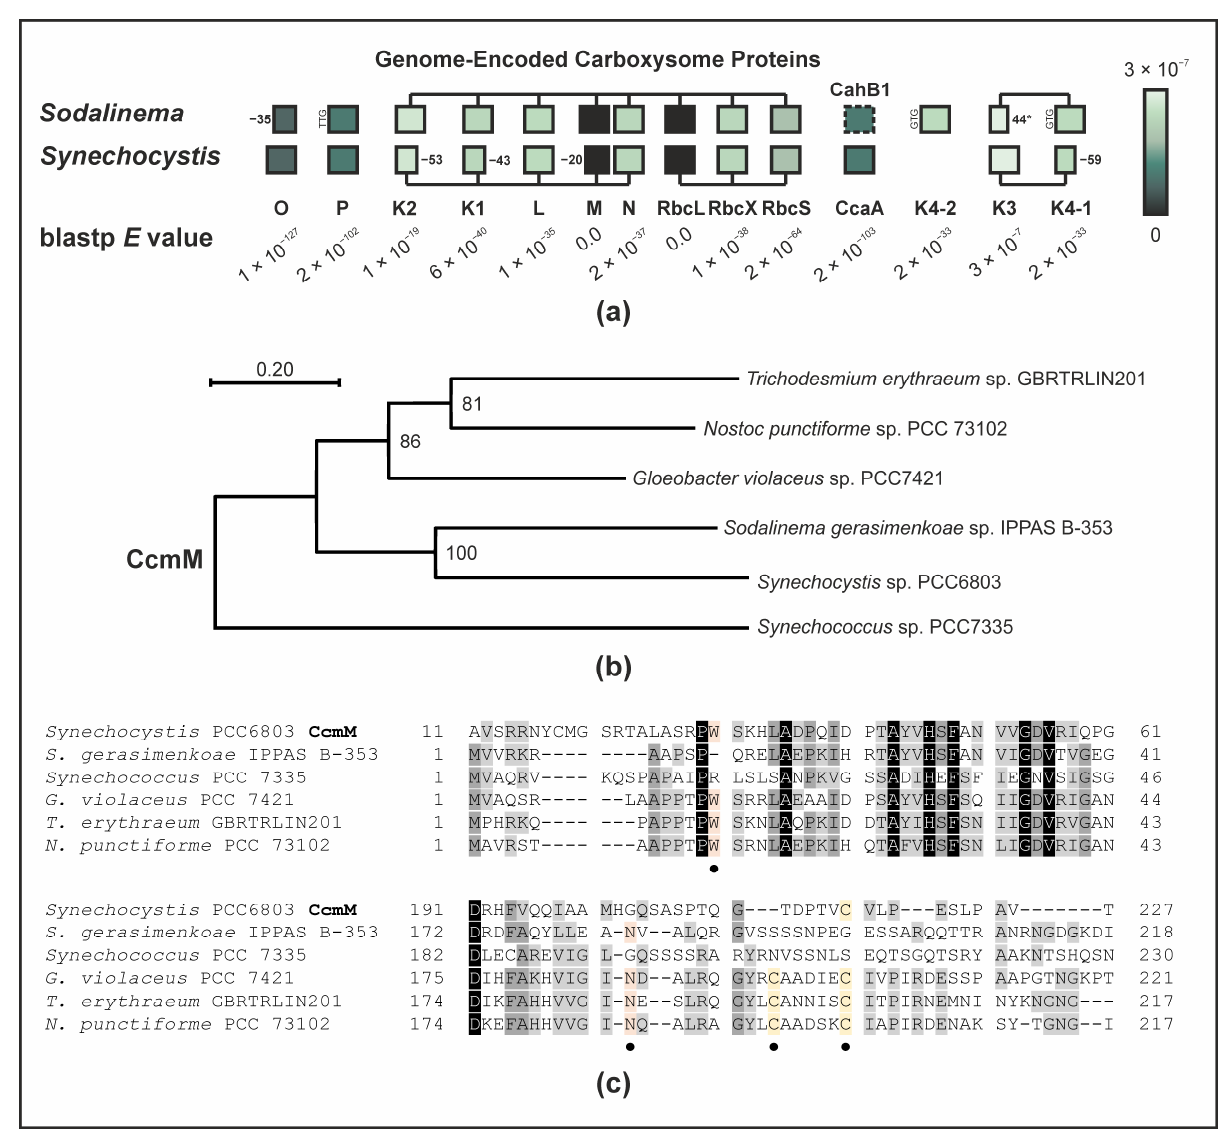
Figure 4. The Sodalinema gerasimenkoae genome encodes all essential carboxysomal proteins but